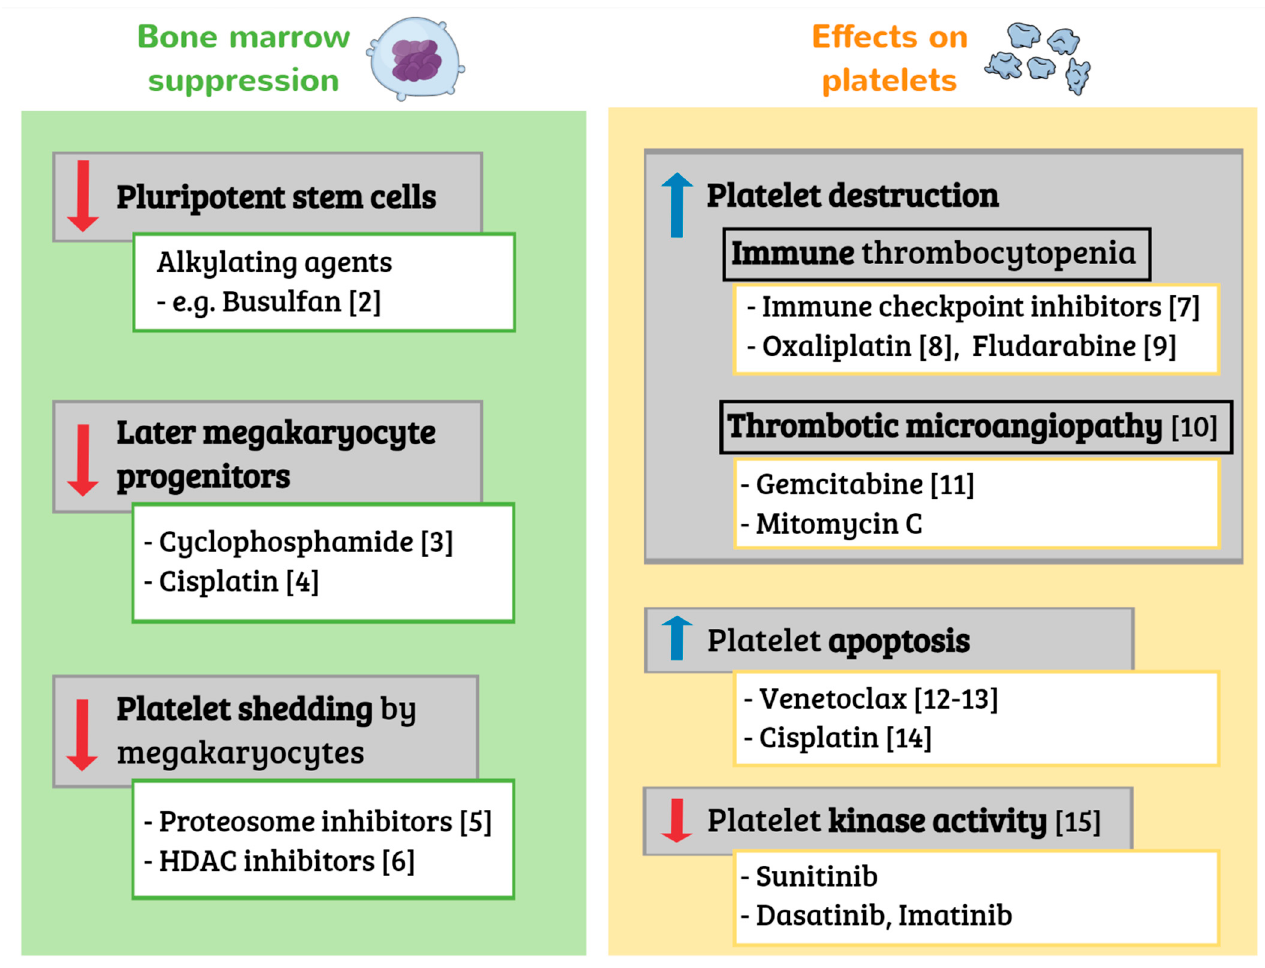
Figure 1. Selected mechanisms of drug induced thrombocytopenia in cancer. Examples of implicated drugs are given for each mechanism. HDAC , histone deacetylase.